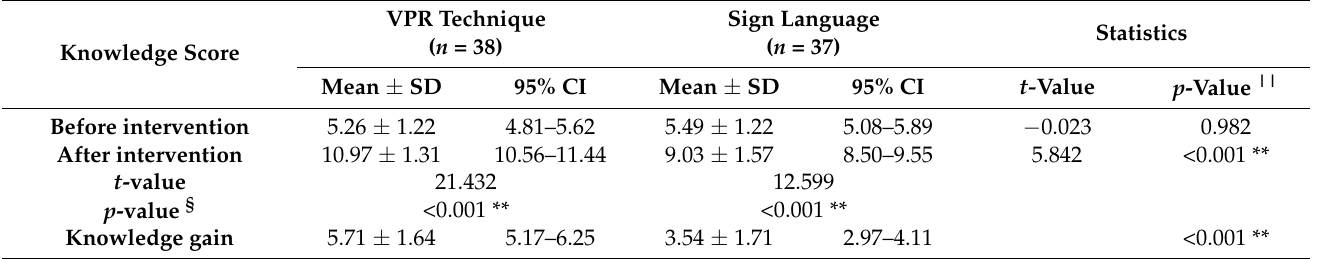
Table 3. Comparison of oral hygiene knowledge score in the study population of VPR technique and sign language technique before and after the